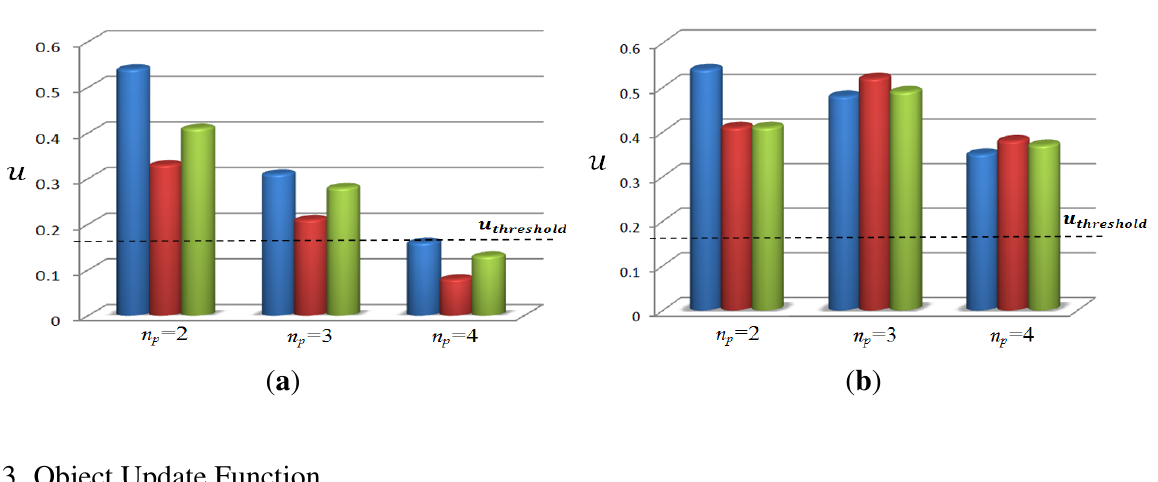
Figure 11. The uncertainty, u , variation of a group of three adjacent cells in which change was detected. ( a ) represents the case of established changes, while ( b ) represents the case of rapid or continuing